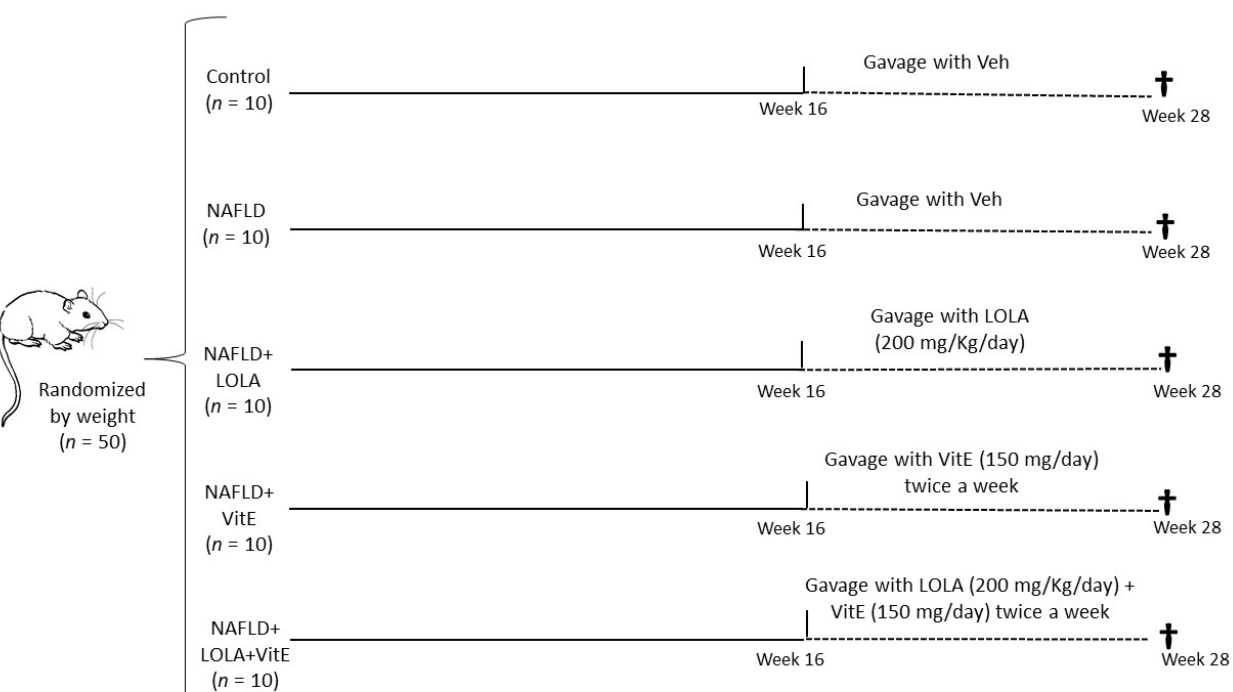
Figure 1. Experimental Design. The control group ( n = 10) received a standard diet and the four intervention groups ( n = 40) received a high-fat and choline-deficient (HFCD) during the 28-week experiment. After sixteen weeks, the control group and NAFLD received gavage daily with a Veh solution; NAFLD+LOLA group received a daily dose of 200 mg/kg; NAFLD+VitE group received twice a week at a dose of 150 mg; and NAFLD+LOLA+VitE group received the combination of the two drugs. After all, the animals were euthanized (†). Abbreviations: LOLA: ornithine aspartate; NAFLD: nonalcoholic fatty liver disease; Veh: vehicle, and VitE: vitamin E.